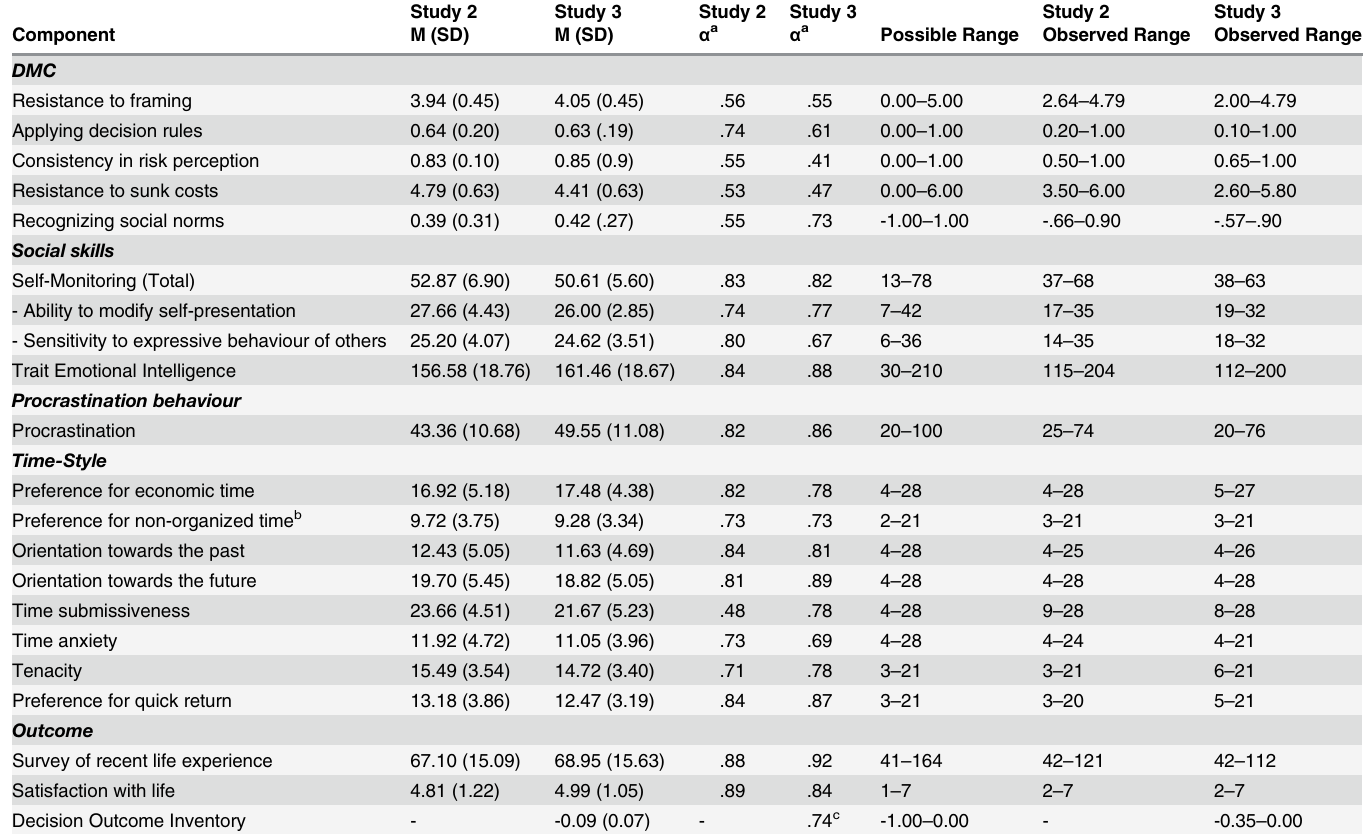
Table 3. Descriptive statistics — Study 2 (N = 90) and Study 3 (N =